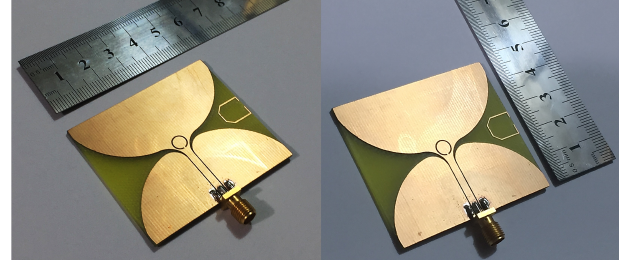
Figure 11: Dual band-notch antenna prototype